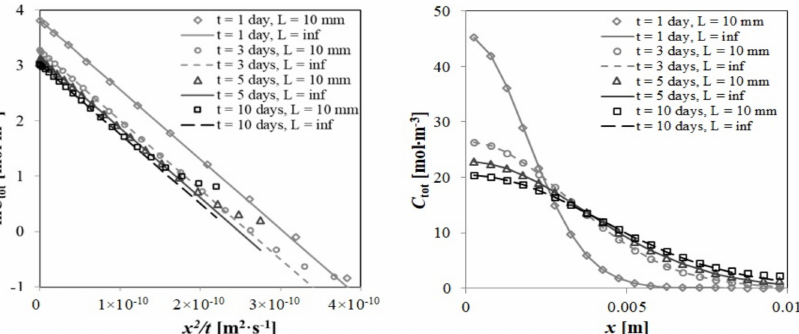
Figure 3. Comparison of the analytical model of tracer total concentration profiles in the infinite porous layer compared with the numerical model in the layer of restricted length ( L = 0.01 m) in regular ( left ) and transformed ( right ) scales. D a = 2 × 10 − 11 m 2 · s − 1 , ρ d = 1400 kg · m − 3 , C 0 = 1 × 10 3 mol · m − 3 , V 0 = 7.5 × 10 − 8 m 3 , d = 0.03 m.